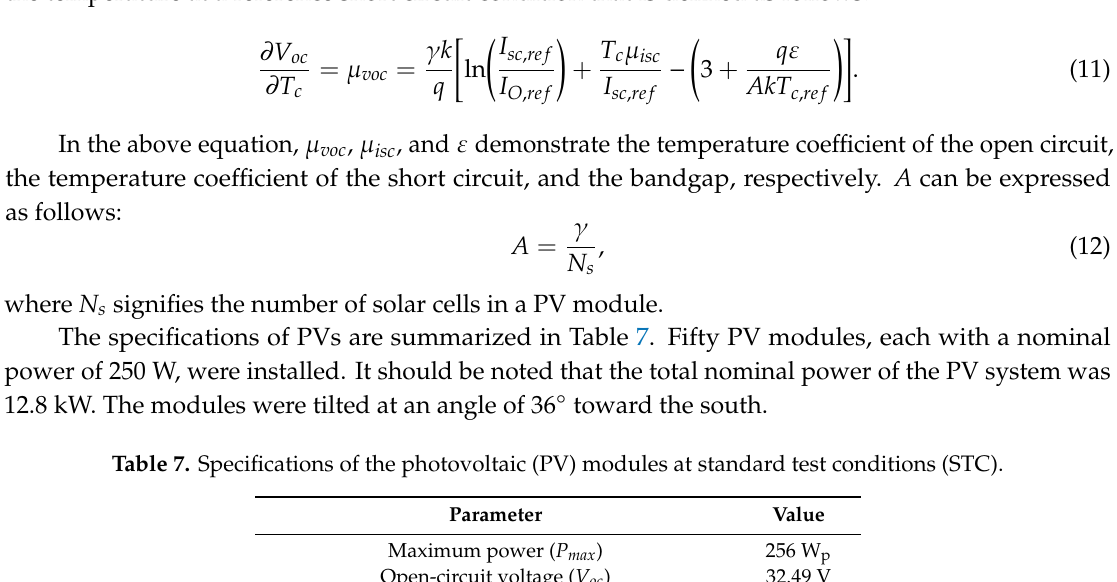
Figure 6. The comparison of the indoor temperature of the single zone building. 3. Results and Discussion Having simulated the building considering various cases, we present the findings in this section. 3.1. Building Orientation The monthly natural gas (NG) and electricity consumption of the building for different orientations are presented in Figures 7 and 8, respectively. It can be seen that the building rotated 30° clockwise has the minimum NG and electricity consumption, with values of 19.5 MWh and 5 MWh, respectively. As shown in Table 8, the total energy is reduced by 1.6 MWh, indicating an energy saving of nearly 6%. The building rotated 60° increases in both NG and electricity consumption by 7.4% and 22.5%, respectively. 0 7